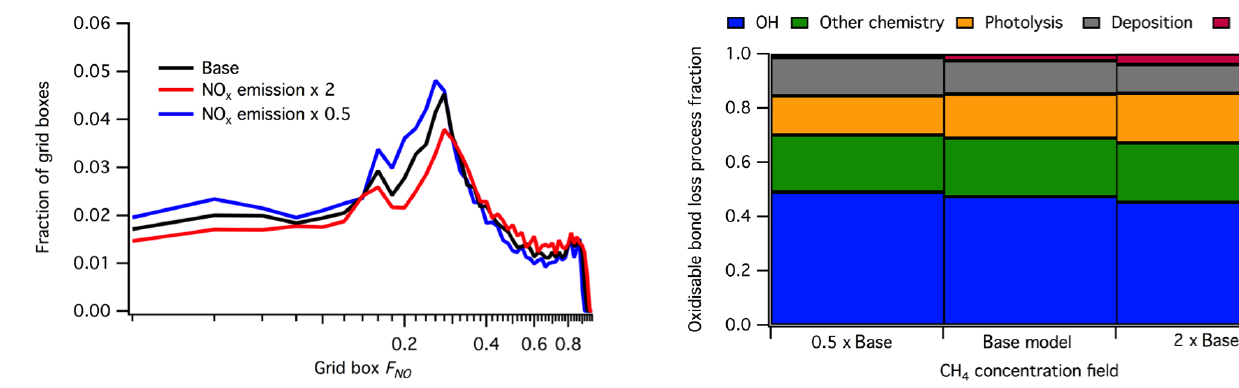
Figure 6. Effect of NO x emission on distribution of F NO values (log scale). F NO values for each model grid box in the base and NO x emission × 0.5 and × 2 simulations, split into 50 × 0.02 width bins.